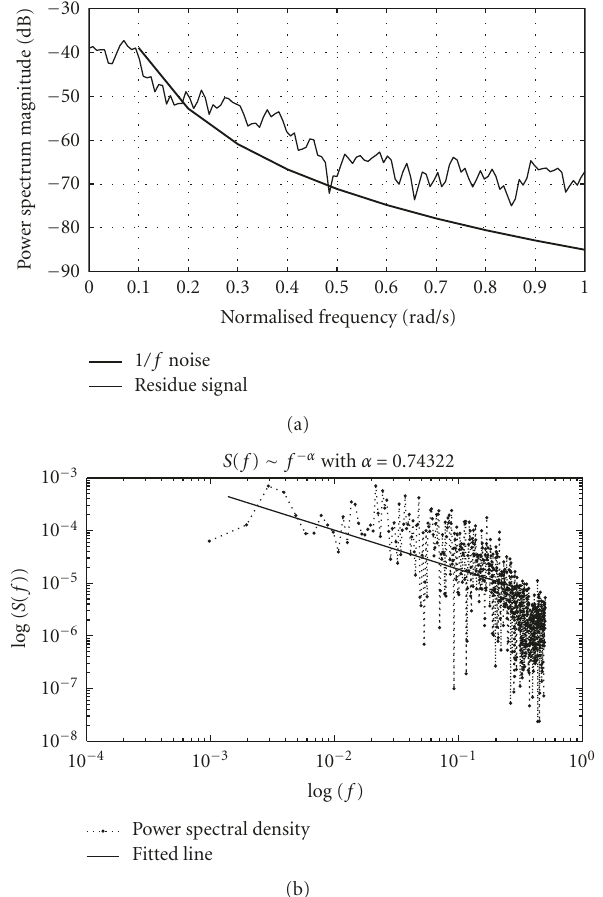
Figure 3: (a) The average power spectral density of the residue signal compared to that of 1 / f noise (b) The estimation of α from the log-log plot of average power spectral density versus frequency of the residue signal.